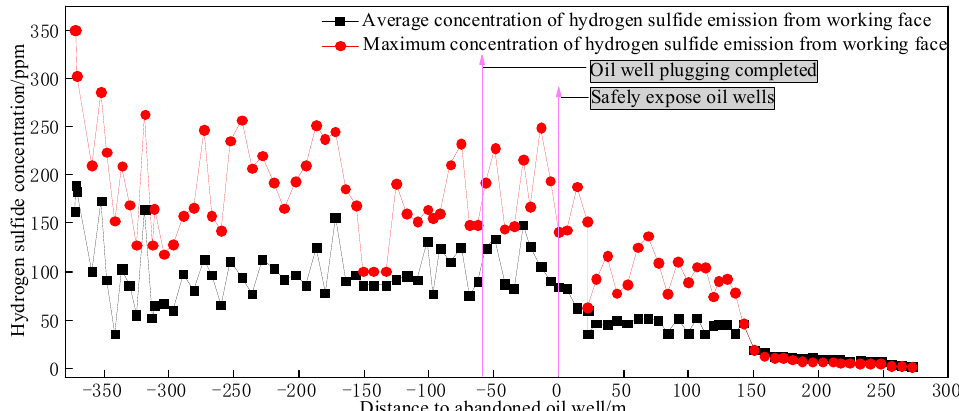
Figure 14. The concentration change curve of hydrogen sulfide emission during the I0104 1 05 working face passing through the Ma tan 31 abandoned oil well.